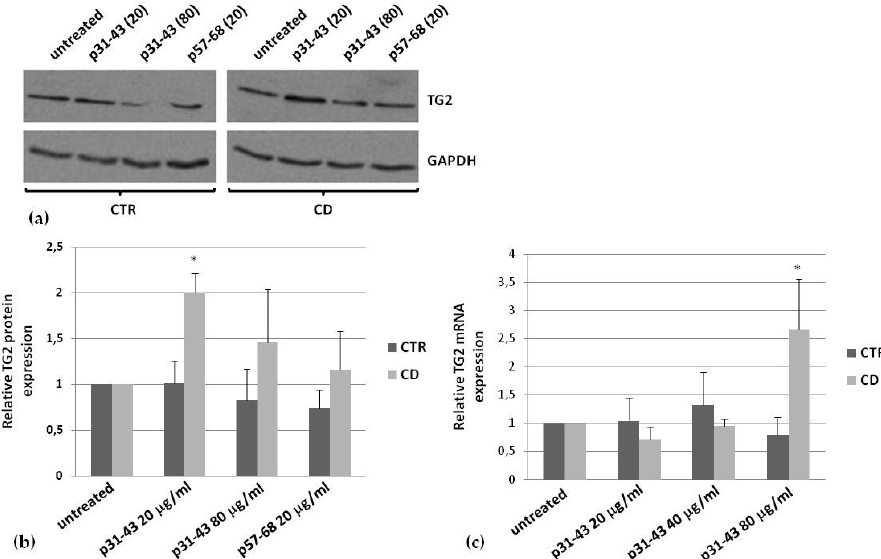
Figure 6. E ff ect of p31–43 on TG2 expression. ( a ) Representative western blot of TG2 expression induced by a treatment for 48 h in the presence of p31–43 (20 and 80 µ g / mL) and p57–68 (80 µ g / mL). ( b ) Densitometric analysis of blots relative to three control and three CD samples. In all experiments, 35 µ g of total proteins were loaded for analysis. GAPDH was used as the internal reference. ( c ) Real-time PCR analysis to quantify relative amounts of TG2 in the presence of 20, 40, and 80 µ g / mL of p31–43, in three control and three CD samples. Asterisks (*) indicate that p < 0.05 vs. respective untreated